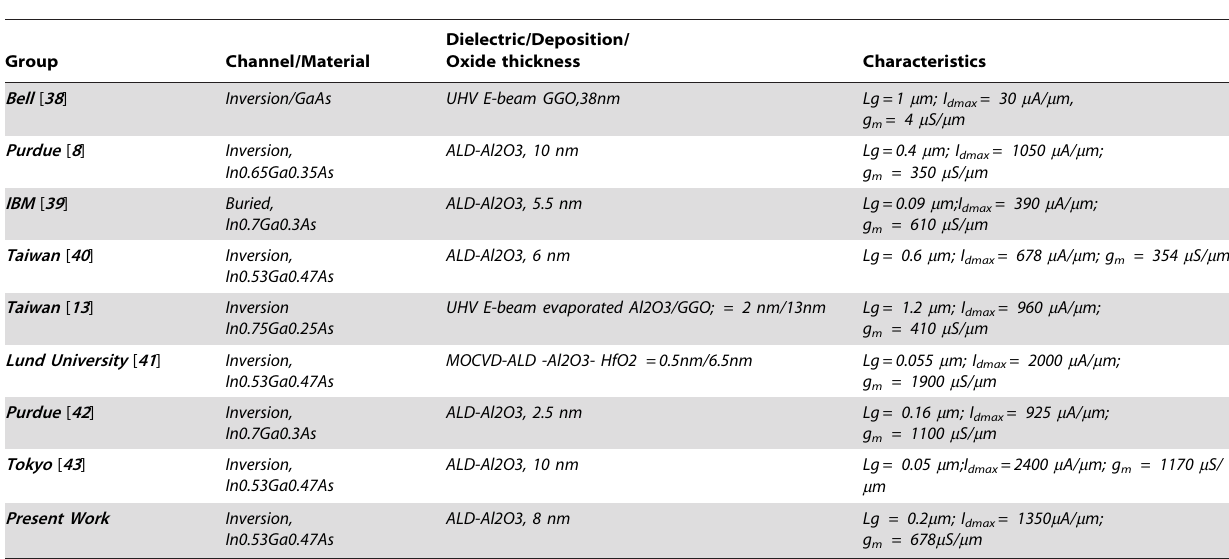
Table 1. Brief summary of the previously published InGaAs inversion-channel MOSFETs.